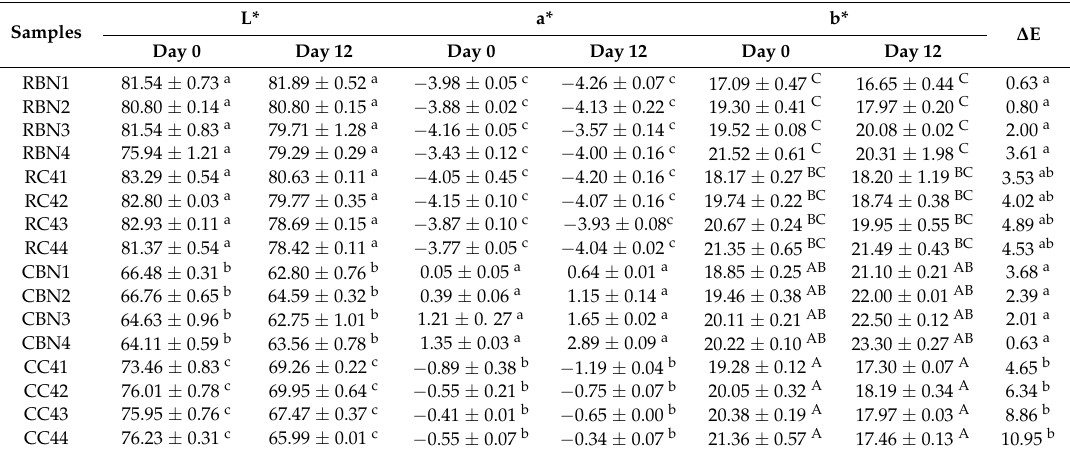
Table 3. Color parameters of dairy dessert systems, 0 and 12